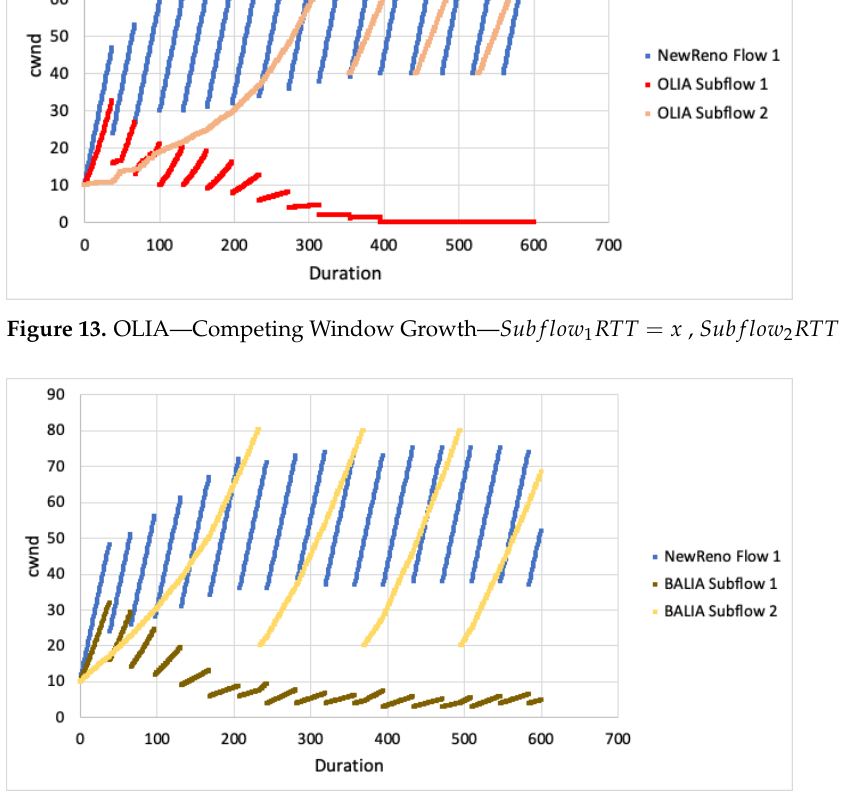
Figure 14. BALIA—Competing Window Growth— Subflow 1 RTT = x , Subflow 2 RTT = 2 x